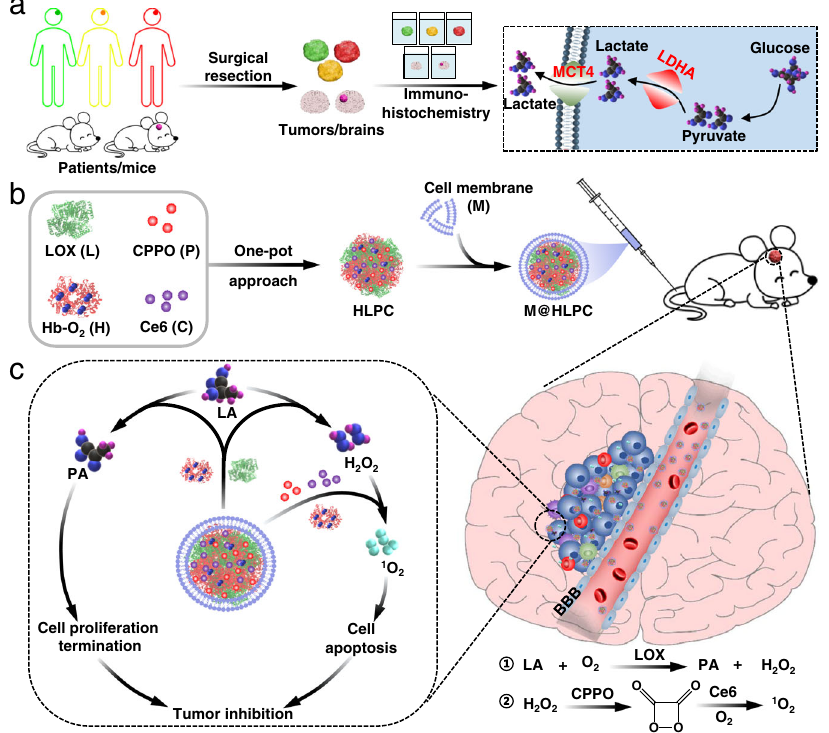
Fig. 1 Schematic illustration of clinical and mice glioma analysis and M@HLPC construction for tumor inhibition. a Analysis of lactate (LA) metabolism- associated indicators (lactate dehydrogenase A, LDHA; monocarboxylate transporter 4, MCT4) in tumor samples from patients and mice gliomas. b Schematic illustration of the construction of M@HLPC. The self-assembly NPs composed of oxygen-carrying Hb-O 2 , LOX, CPPO, and Ce6 (denoted as HLPC) are fabricated using a one-pot approach, followed by coating with the M prepared from glioma cells. c Targeted accumulation of M@HLPC in GBM and subsequent synergistic therapy upon the combination of LA metabolic therapy and chemiexcited PDT. M@HLPC are able to cross the BBB and actively target GBM due to the homotypic targeting ability of glioma cell membranes. After accumulation in the glioma site, the LOX in M@HLPC can selectively convert the intra-tumor LA into PA and H 2 O 2 upon consumption of O 2 carried by Hb ( ① ). Furthermore, the in situ-produced PA can act as a signaling molecule to repress histone gene expression, delay cell cycle progression, and terminate cell proliferation. At the same time, the released H 2 O 2 can react with CPPO to produce chemical energy, which can activate the photosensitizer Ce6 to generate 1 O 2 and induce cell apoptosis ( ② ), achieving chemiexcited PDT without laser irradiation. This design enables M@HLPC to achieve targeted accumulation in GBM and then support both LA metabolic therapy and chemiexcited PDT in a synergistic